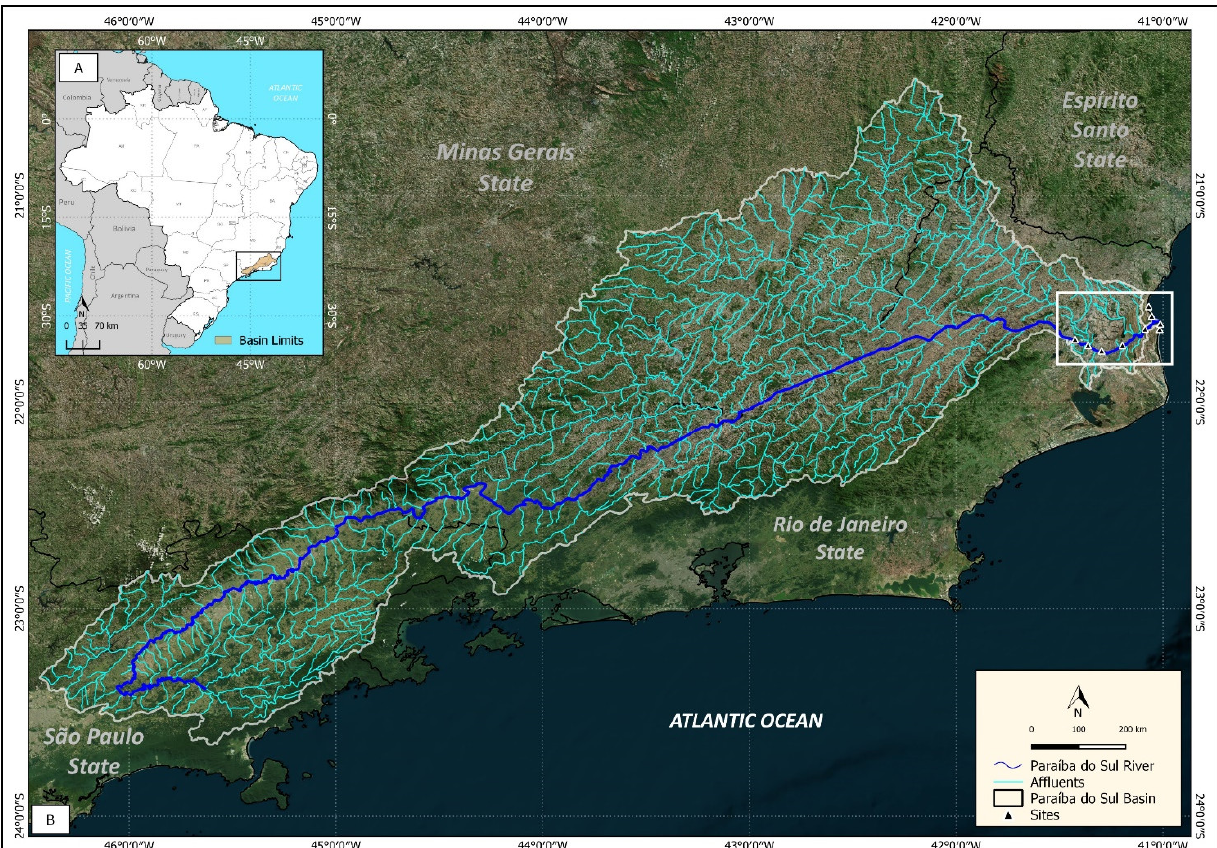
Figure 1. Location of the study area. ( A ) Location in Brazilian territory. ( B ) Paraíba do Sul hydrographic basin (PSHB). The study area is highlighted by the white square at the river mouth. For details, see Figure 2. The geographic coordinate system is UTM Sirgas 2000 [68,69].